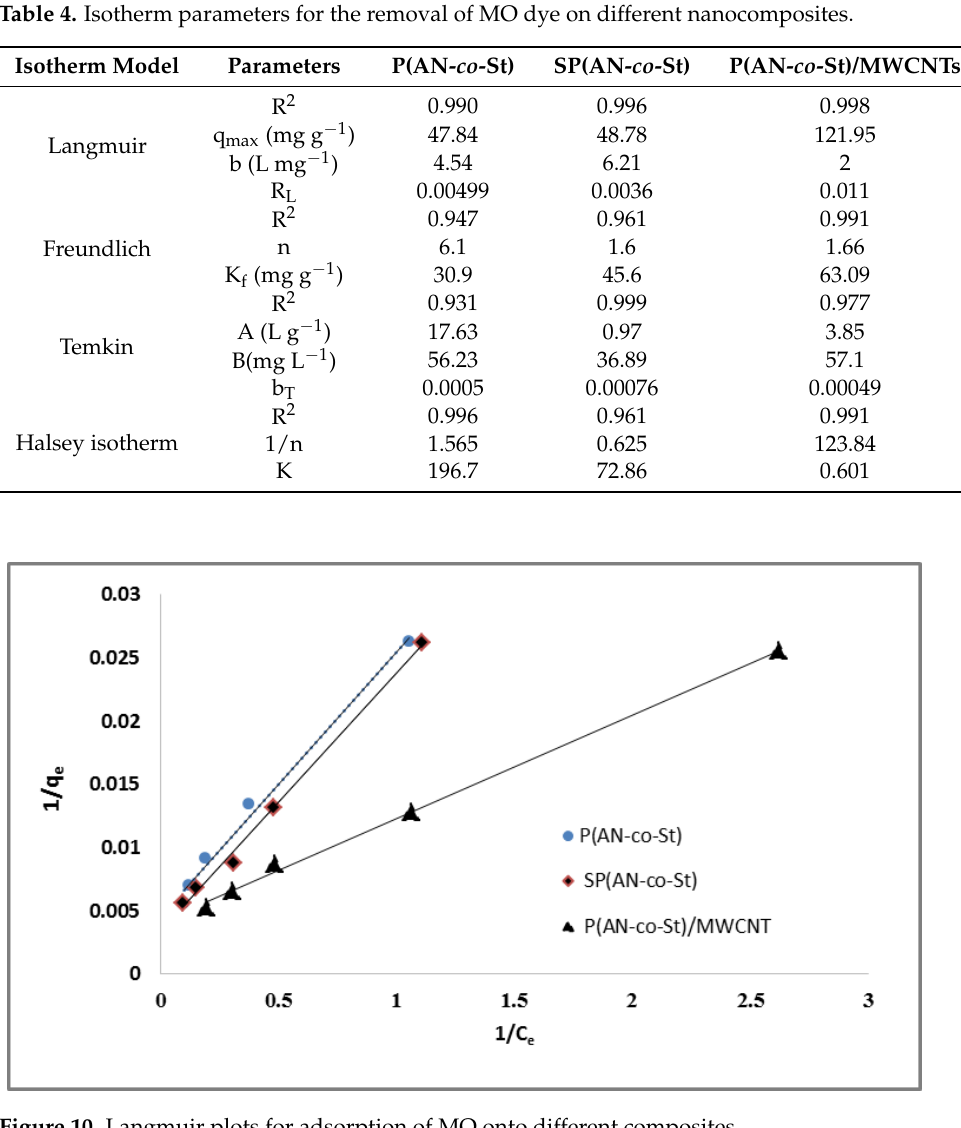
Figure 12. Temkin plots for adsorption of MO onto different composites.